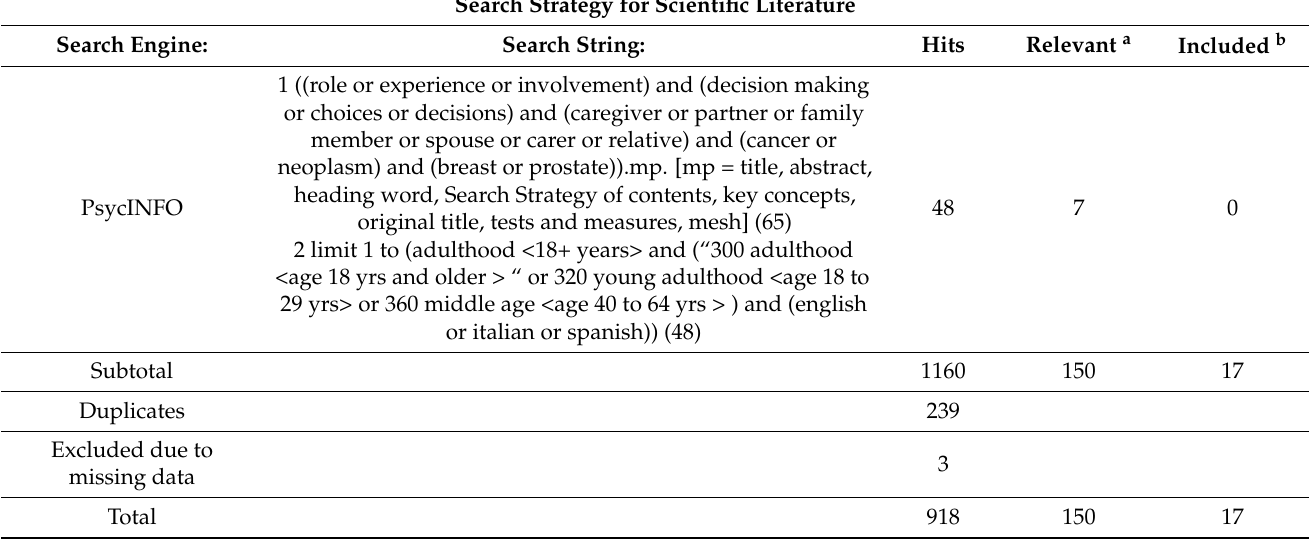
Table A1. Cont. Search Strategy for Scientific